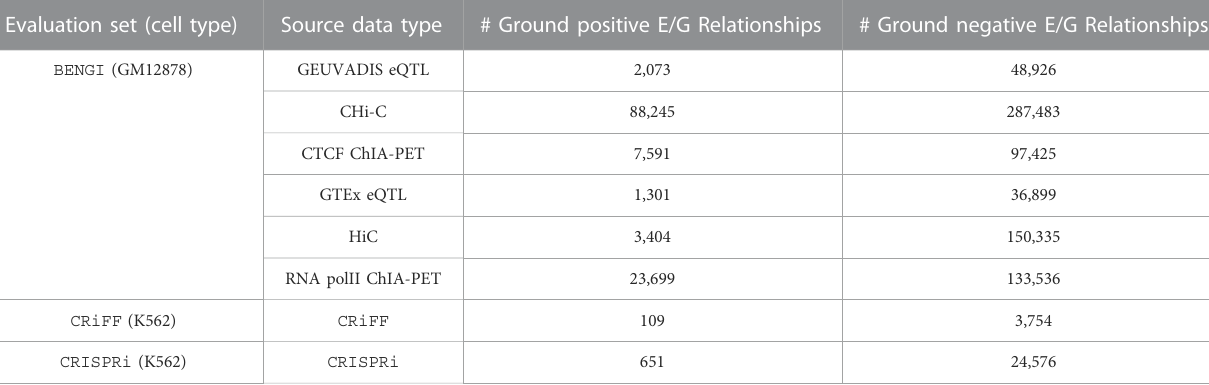
TABLE1NumberofgroundpositiveandgroundnegativeE/Grelationshipsforeachofthethreeevaluationsetsconsidered,namely, BENGI , CRiFF and CRISPRi . Evaluation set (cell